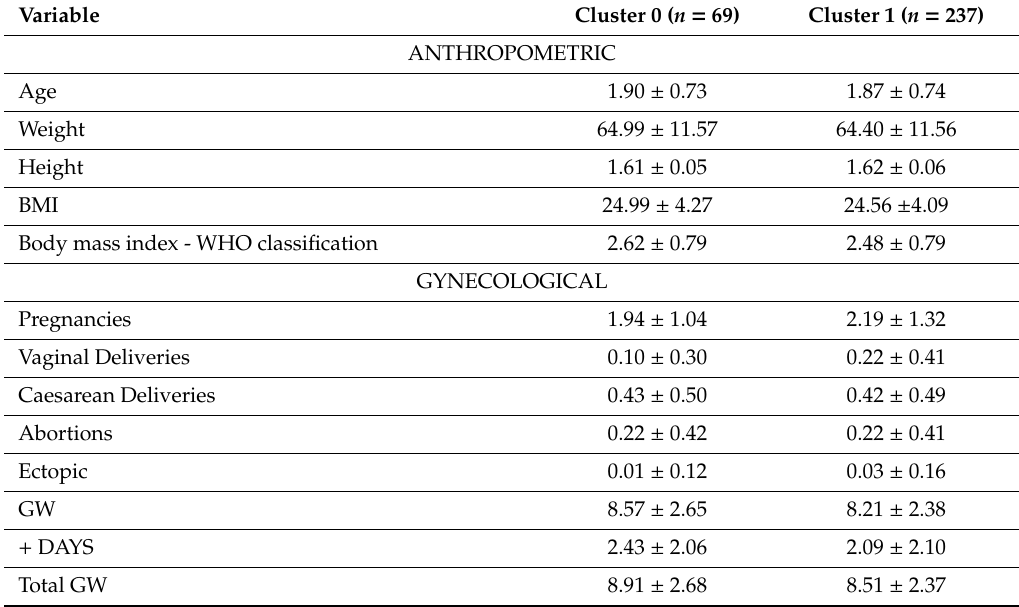
Table 7. Characteristics stratified by risk factors. Features are presented as mean ±